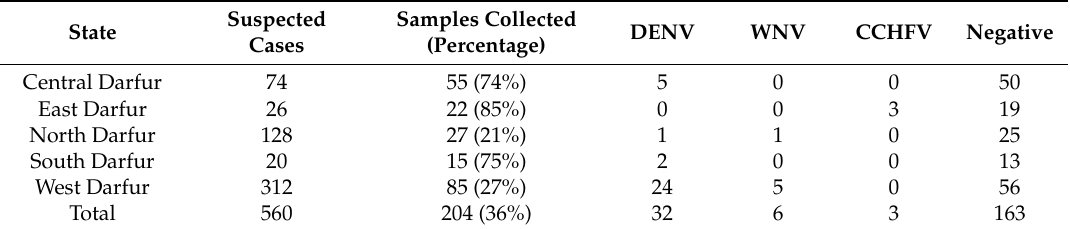
Table 1. Number of hemorrhagic fever suspected cases, ratio of blood samples obtained and lab results per state of Greater Darfur from 29 August 2015 to 16 February